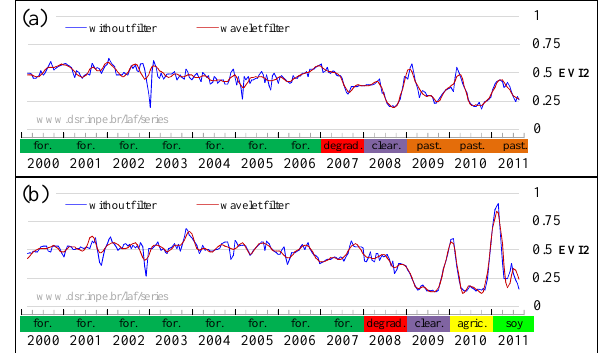
Figure 2. EVI2 temporal profile for two deforested polygons: (a) Forest from 2000 to 2006, transition from forest to pasture in 2007 and 2008, and pasture after 2009; and (b) Forest from 2000 to 2007, transition from forest to bare soil in 2008 and 2009 followed by agriculture use in 2010 and soy in 2011. Abbreviations: for. (forest); degrad. (degradation); clear. (total clearing of the area); past. (pasture); agric. (agriculture).